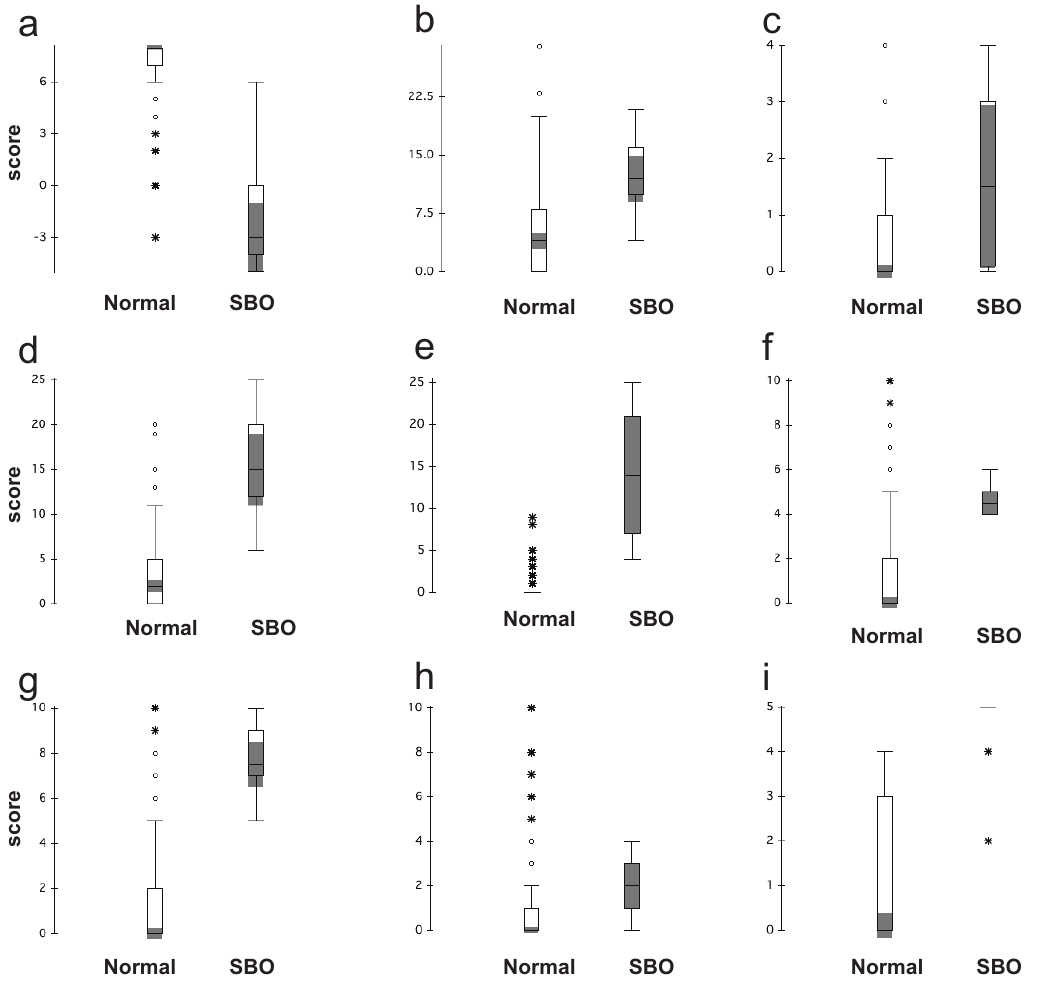
Figure 1. Box and whisker plots for normal and SBO populations for each domain in the SBO survey. Each domain is represented separately: ( a ) diet; ( b ) pain; ( c ) medication; ( d ) gastrointestinal symptom; ( e ) quality of life; ( f ) average pain on the pain scale; ( g ) maximum level of pain on the pain scale; ( h ) minimum level of pain on the pain scale; and ( i ) duration of pain. The box represents the 25% to 75% percentile values; the horizontal line is the median. The whiskers on the box show the main data while extreme outliers are denoted by open circles and very extreme outliers are denoted by a starburst. The shading shows the 95% confidence interval around the